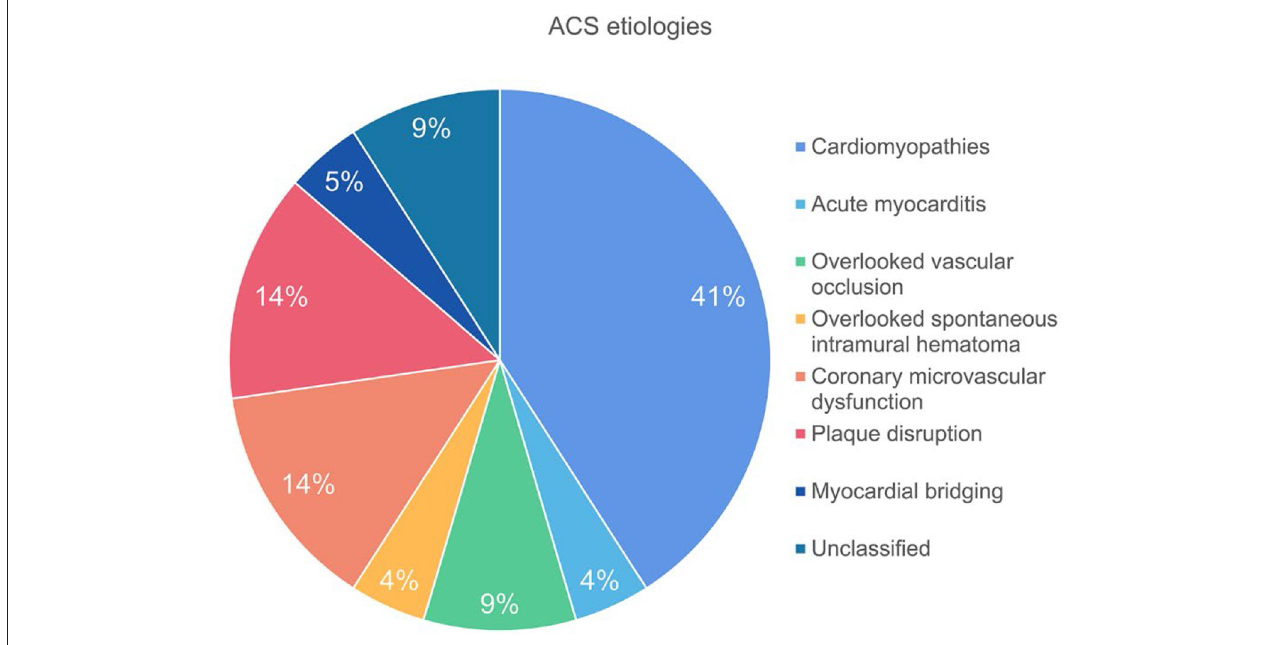
FIGURE 5 | Pie chart of ACS